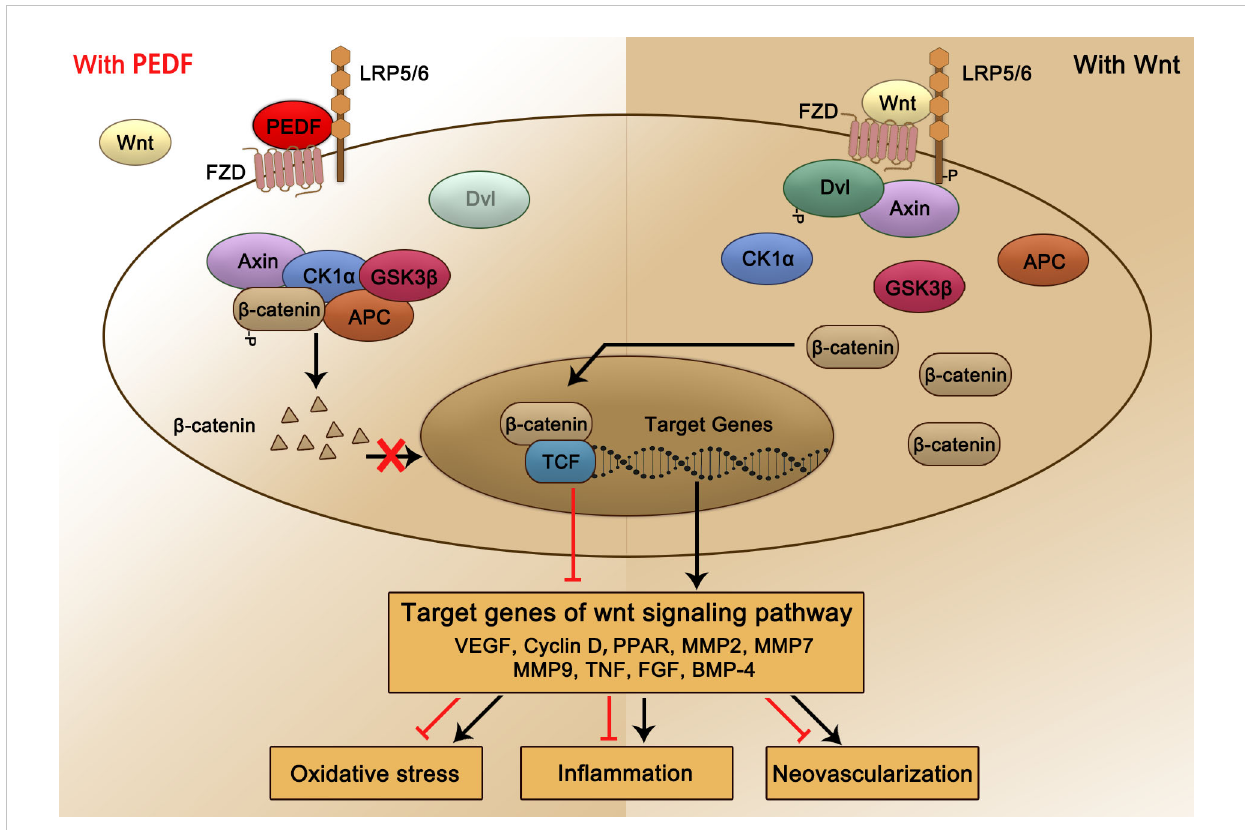
FIGURE 2 Schematic representation of PEDF-activated LRP6 signaling. PEDF binds to the Fzd-LRP5/6 complex and activates the canonical Wnt/ b -catenin pathway. The key protein Dvl is recruited and phosphorylated, subsequently forming a destruction complex that also includes Axin, CKIa, GSK3 b , and APC tumor suppressors and inhibiting the phosphorylation and nuclear translocation of b -catenin, which is bound. This process leads to changes in target gene transcription and expression, which reduce the occurrence of relevant pathological consequences, such as oxidative stress, in fl ammation, and NV. Dvl, dishevelled; CKIa, casein kinase Ia; GSK3 b , glycogen synthase kinase 3 b